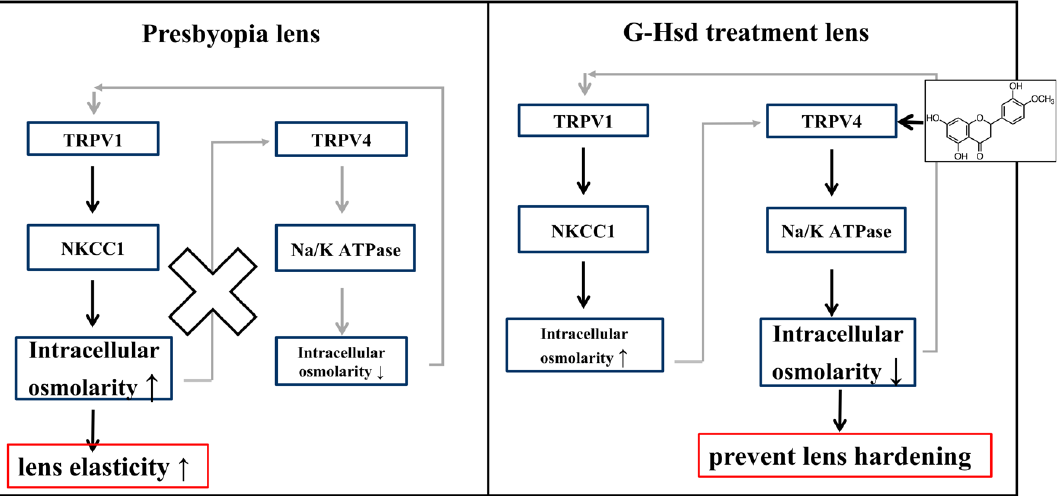
Figure 6. Inhibitory mechanisms of presbyopia onset by G-Hsd consumption. G-Hsd consumption affects TRPV4 localization and activates TRPV4 and Na/K ATPase pump, which decrease the intracellular osmolarity of the lens and prevent lens hardening.